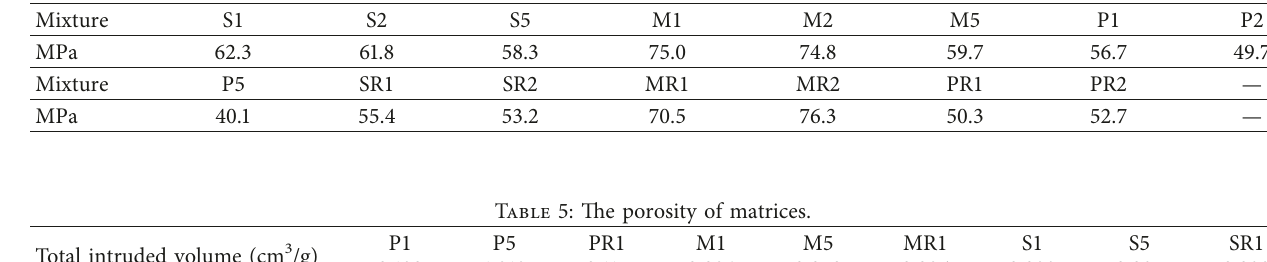
Table 4: Compressive strength of prepared matrices (7 days).